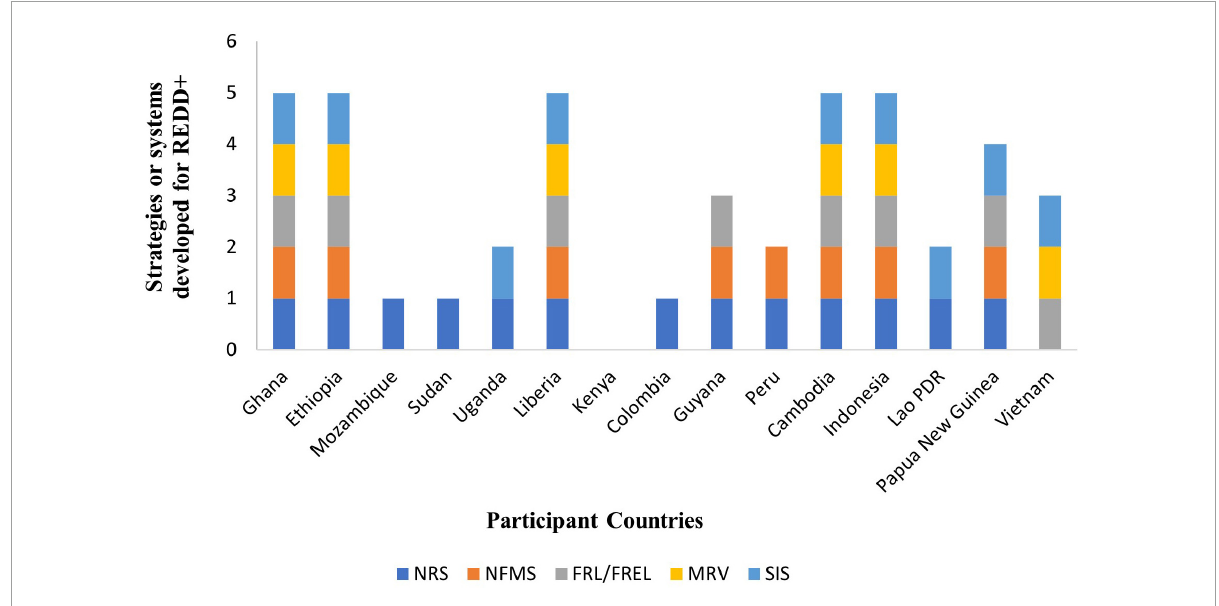
FIGURE7 Participant countries and various key strategies and systems developed for